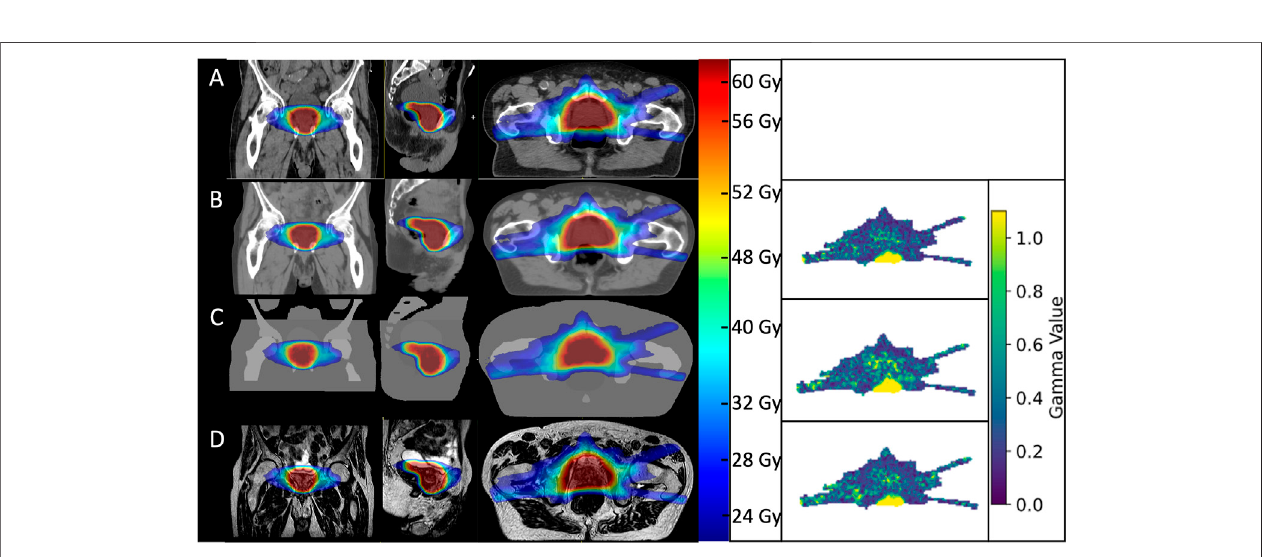
TABLE 6 | Results of the Wilcoxon signed rank test for testing each planning approach against the others. Structure